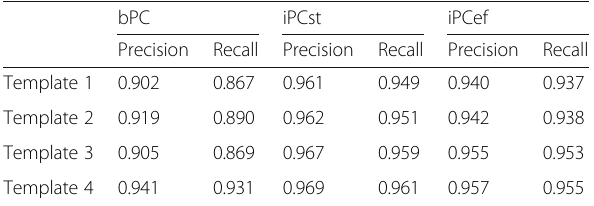
Table 9 Precision and recall of the MPM generations, as obtained using target-labeling methods for bPC, iPCst, and iPCef bPC iPCst iPCef Precision Recall Precision Recall Precision Recall